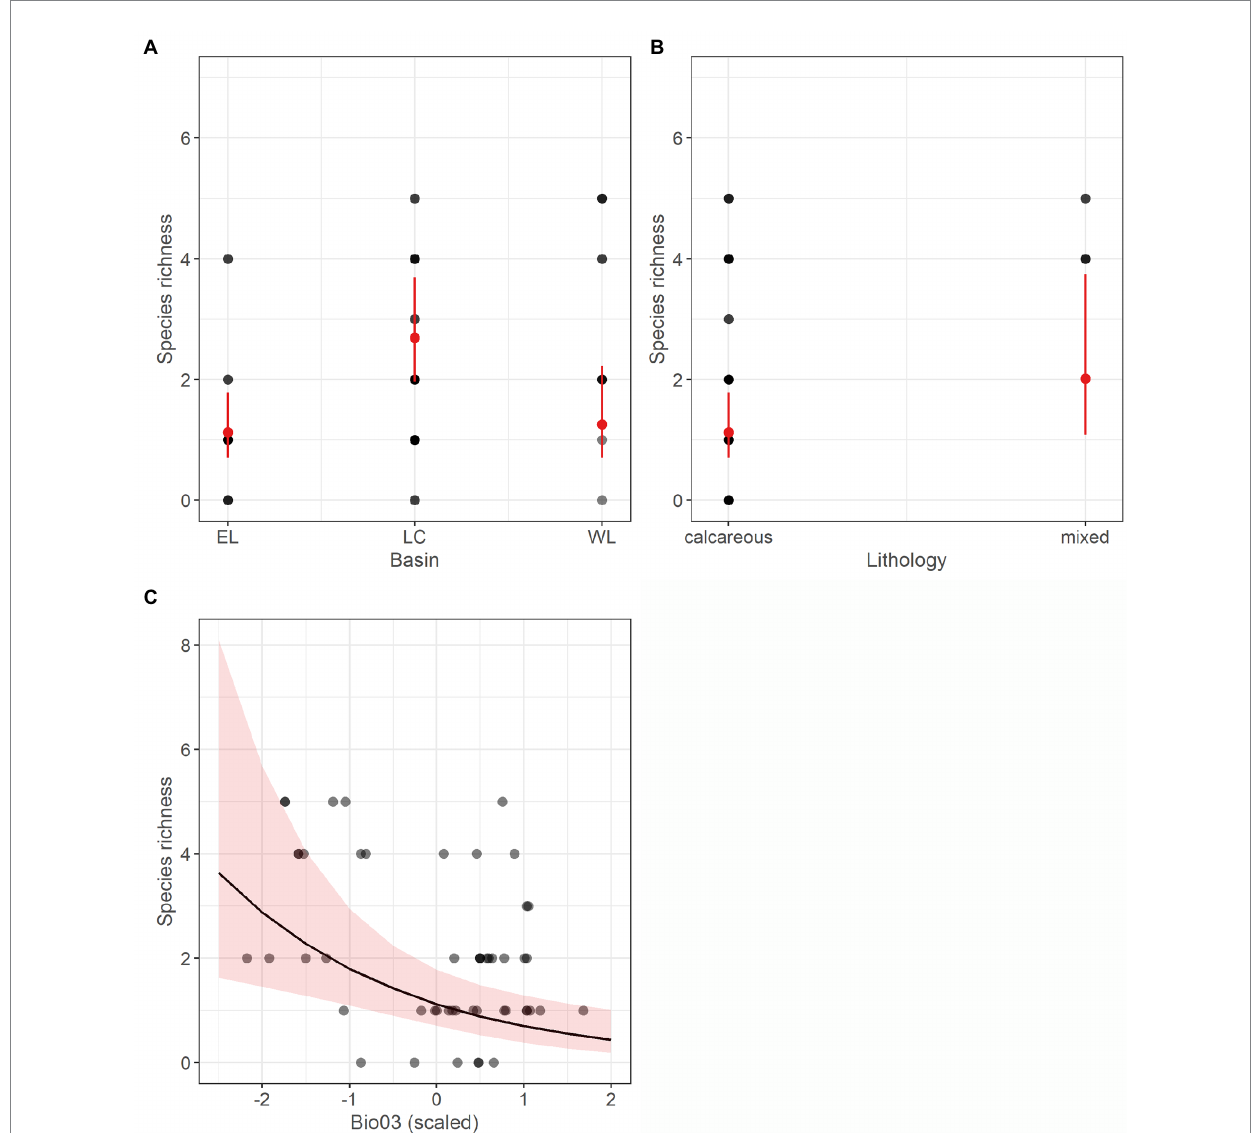
FIGURE 3 Marginal response plots showing the effect of drainage basin (A) , lithology (B) and scaled isothermality (Bio03) values (C) on predicted species richness of stygobitic copepods, as resulting from the corresponding Generalized Linear Model. In (A) and (B) , red dots and related bars show predicted values and the corresponding 95th percentile confidence interval. In (C) , the black curve corresponds to predicted marginal response with the surrounding shaded area representing the 95th percentile confidence interval. In all the three plots, grey-scale dots represent observed values, with darker dots indicating multiple observations with the same richness